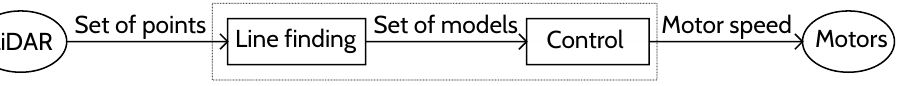
Figure 1. Overview of the approach: the LiDAR sensor provides points, and, from those points, lines (models) are extracted and from those lines the motor speeds are deduced.